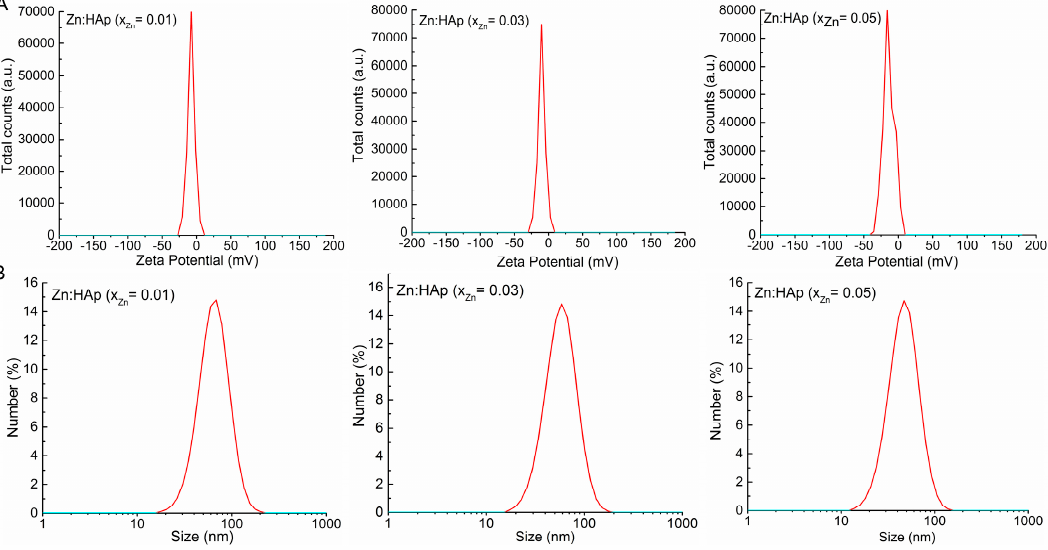
Figure 5. Colloidal characteristics of the Zn:Hap, Ca 10 − x Zn x (PO 4 ) 6( OH) 2 samples synthesized with 0.01 ≤ x Zn ≤ 0.05: ( A ) zeta-potential distribution curves; and ( B ) hydrodynamic size distribution curves images.